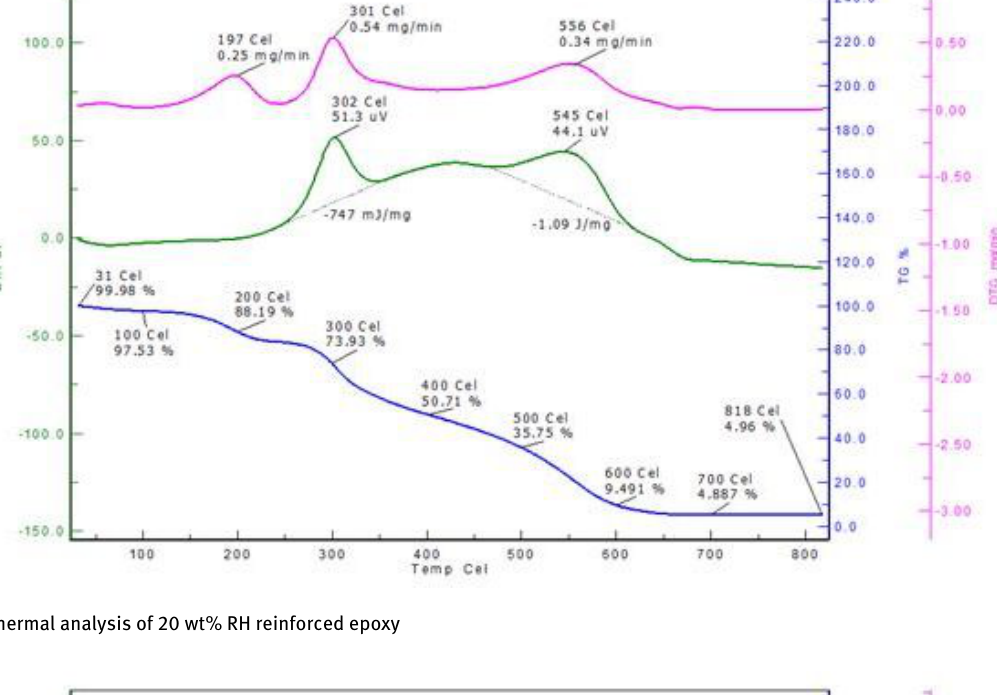
Figure 11: Thermal analysis of 20 wt% RH reinforced epoxy